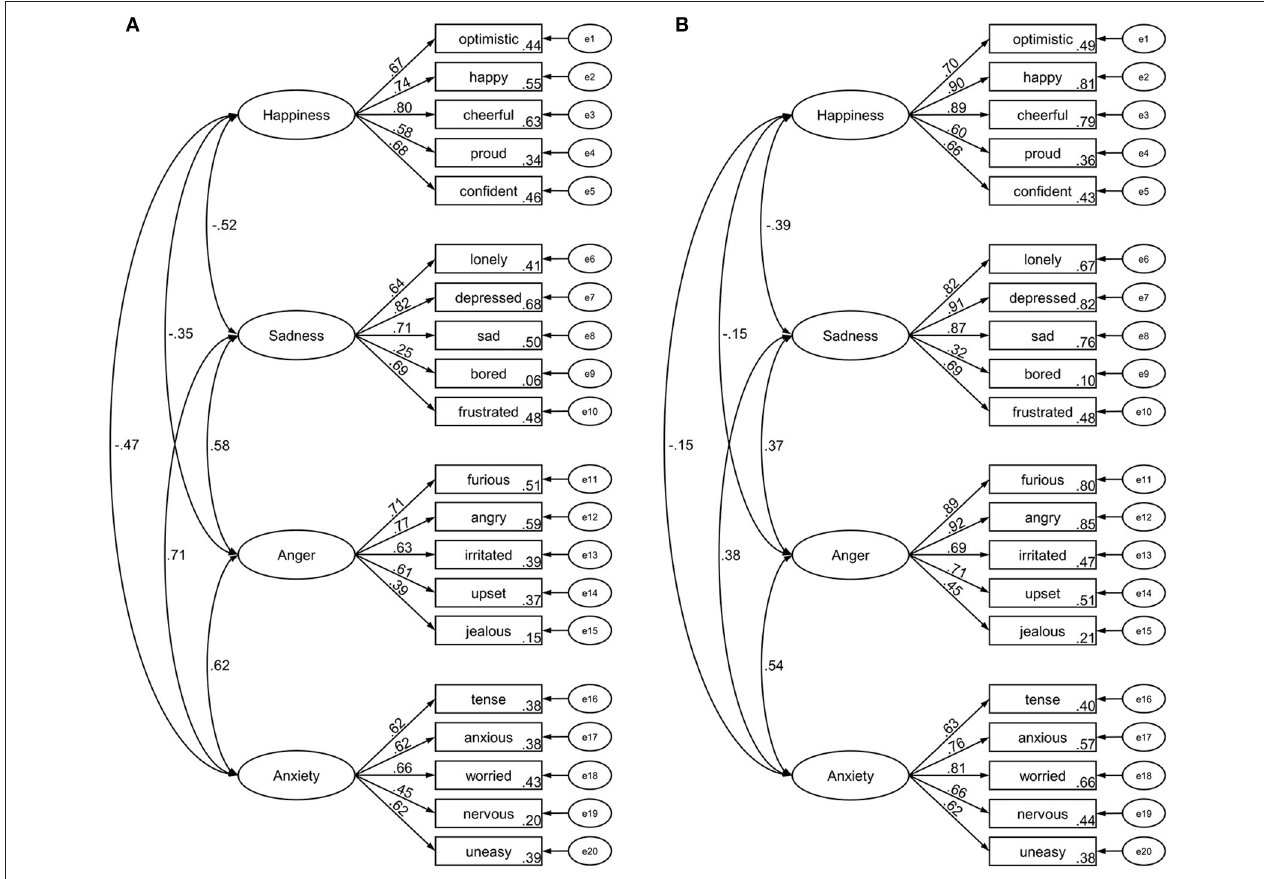
FIGURE 3 | Standardized factor loadings and latent factor intercorrelations of the Salzburg Emotional Eating Scale in study 2 (A) and study 3 (B) .